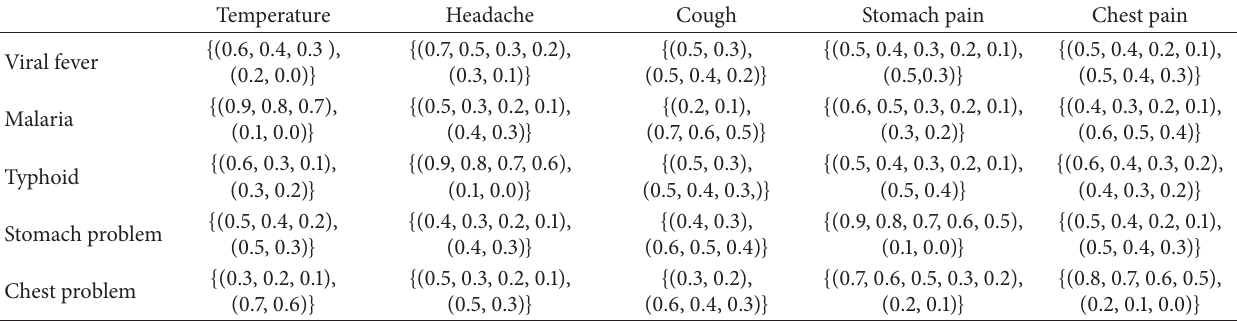
Table 1: Symptoms characteristic of the considered diagnoses.